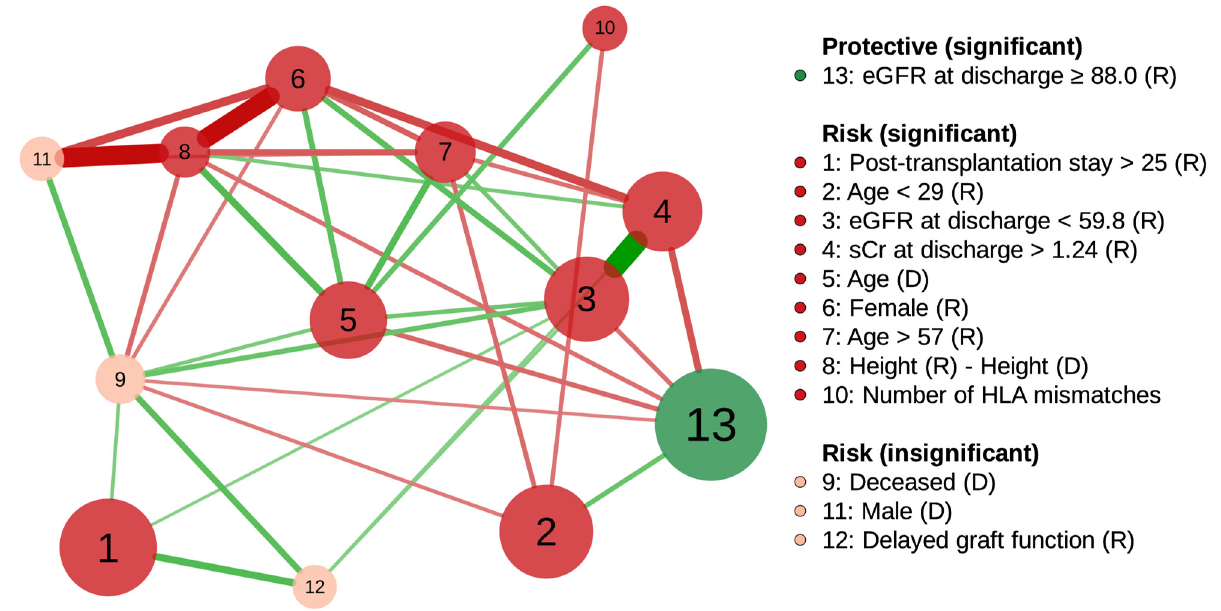
Figure 4. Partial correlation network of factors associated with one-year renal allograft dysfunction using graphical lasso regularization. Node size is proportional to the effective size of the odds ratio. The nodes are positively (risk) or negatively (protective) related to graft function decline. Green and red edges represent positive and negative correlations between the nodes, respectively. The edge with the highest absolute weight has full-color saturation and the widest width. Abbreviations: R, recipient; D, donor; eGFR, estimated glomerular filtration rate (mL/min/1.73 m 2 ); sCr, serum creatinine (mg/dL); HLA, human leukocyte antigen.